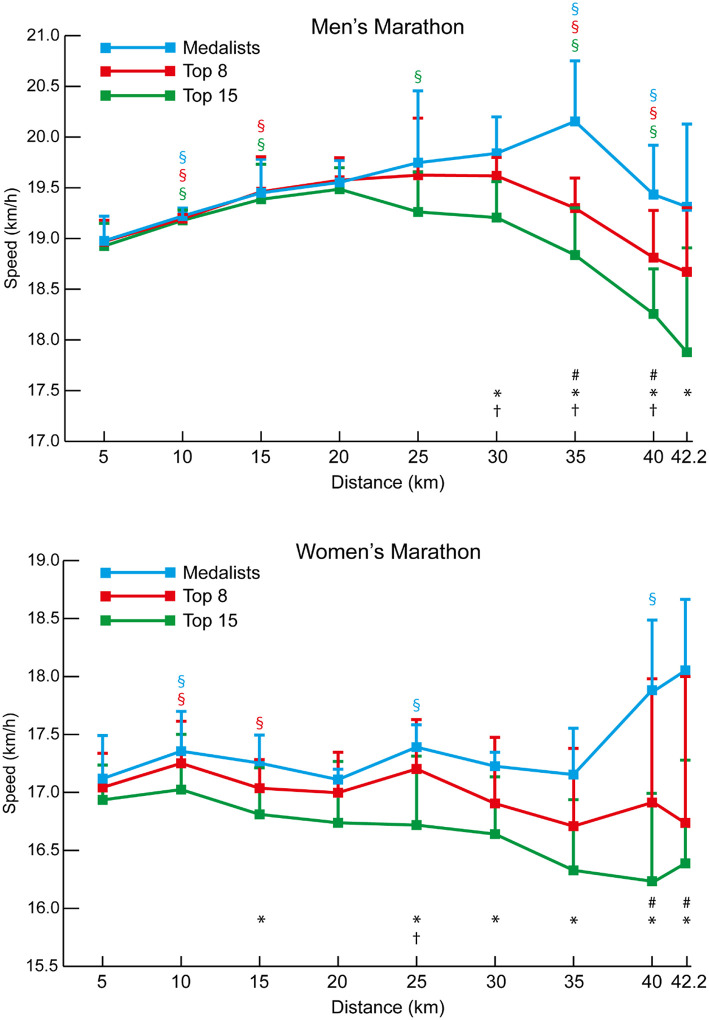
The mean (+ SD) 5-km and final 2.2-km segment speeds for each group of men and women marathon athletes. Differences between successive segments (p < 0.05, d ≥ 0.61) are represented by § (blue for medalists, red for Top 8, and green for Top 15). Differences in segment speed between groups (p < 0.05, d ≥ 0.61) have been annotated for medalists vs. Top 8 (#), medalists vs. Top 15 (*), and Top 8 vs. Top 15 (†).